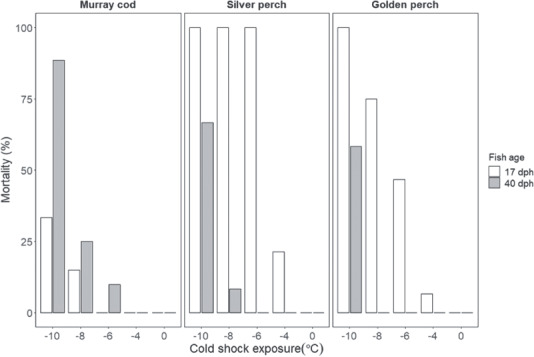
Mortality (%) of Murray cod, silver perch and golden perch occurring within 2 min of exposure to cold shock treatments (−10, −8, −6, −4 and 0°C) from an initial temperature of 23°C. Two age groups are assessed; old (40 ± 3 dph) and young (17 ± 1 dph)